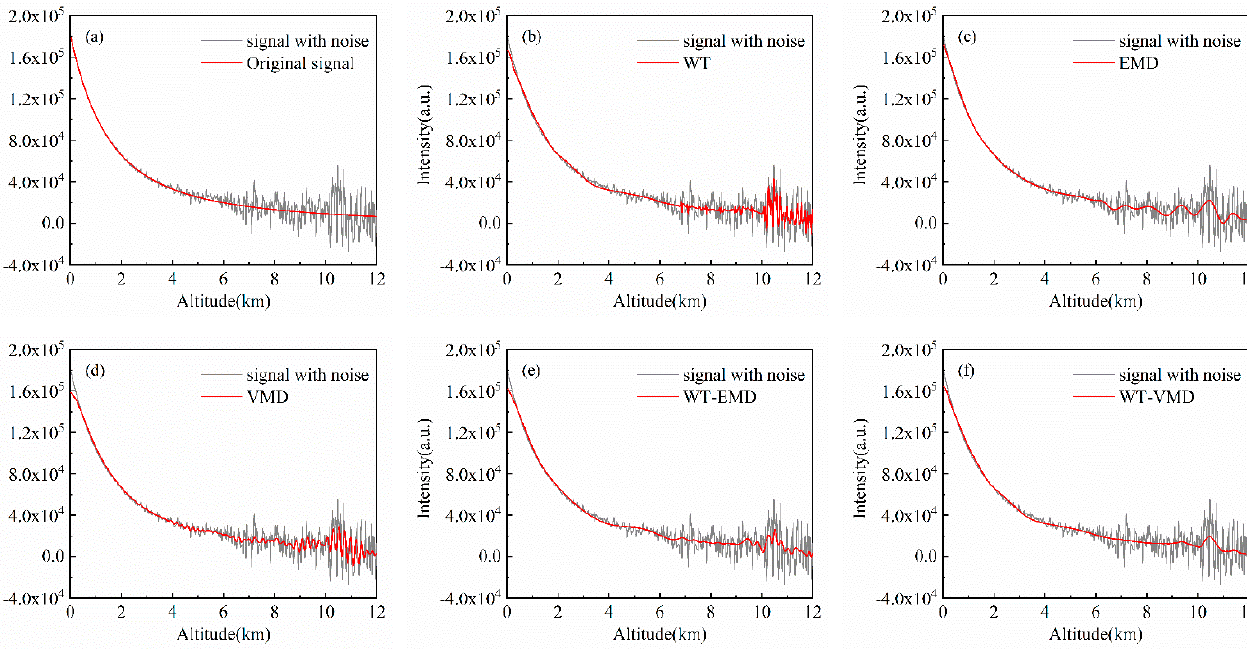
Figure 3. Experimental results of denoising of 100-pulse cumulative simulation signals (no pollu- tion): ( a ) original signal; ( b ) WT; ( c ) EMD; ( d ) VMD; ( e ) WT-EMD; ( f ) WT-VMD.